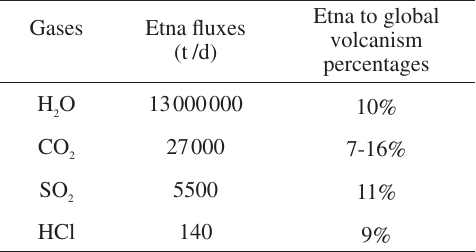
Table I. Main gas components of the Etna plume, ty- pical emission rates and the Etna average fluxes compared to global volcanism (Jaeschke et al ., 1982; Allard et al ., 1991; Symonds et al ., 1994).